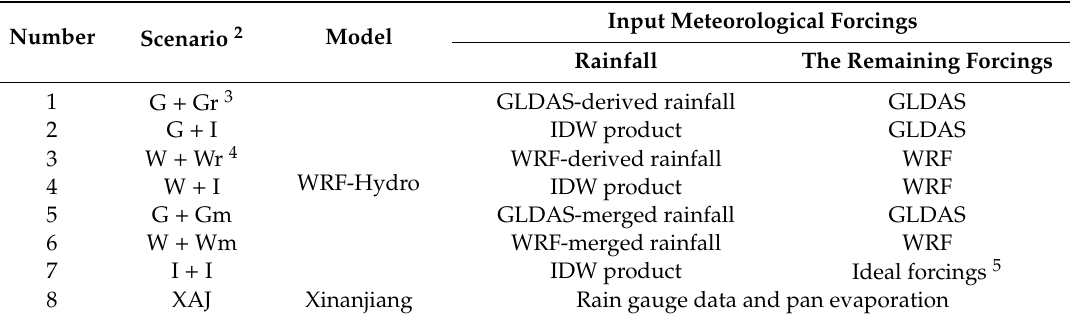
Table 7. The key information of eight forcing scenarios in this study 1 .